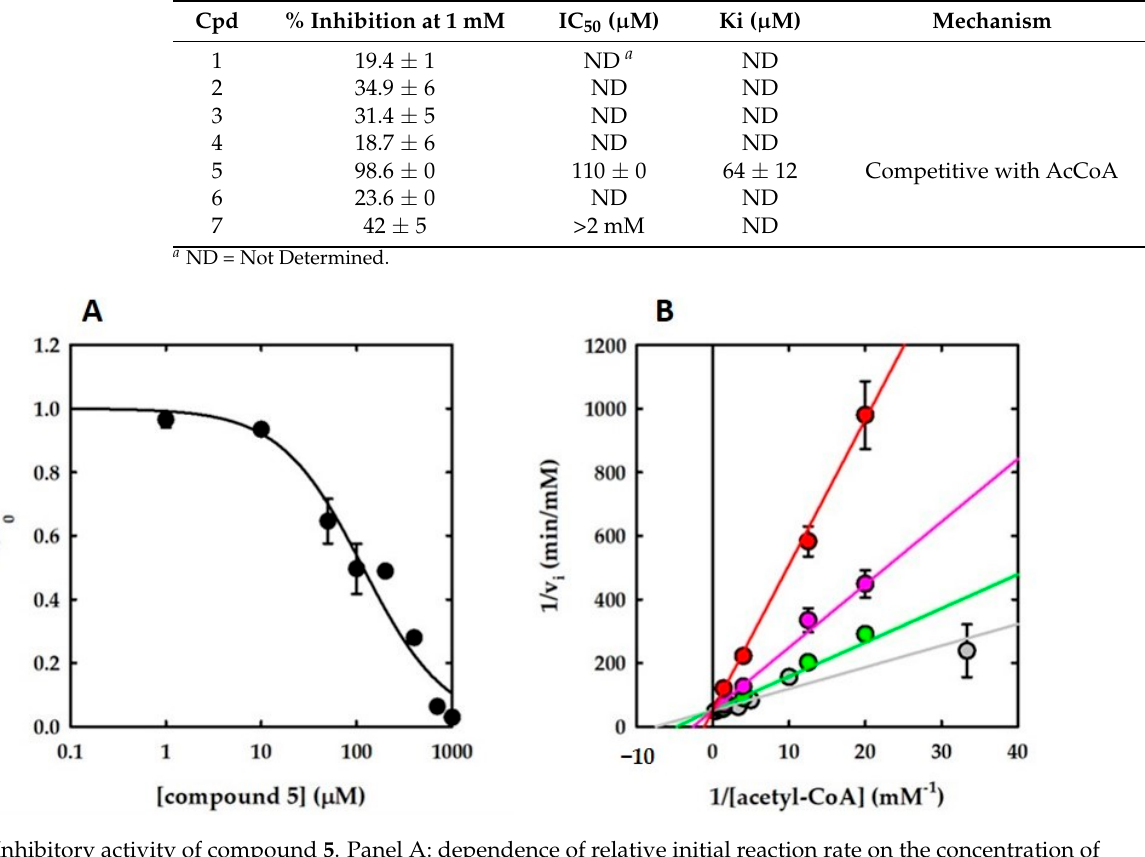
Figure 4. ( A ) docking pose of compound 5 in AcCoA pocket in EcSAT (alignment of structures with pdb code 1T3D and pdb code 1SSM). ( B ) Overlay of the docking pose of compound 5 and AcCoA structure.